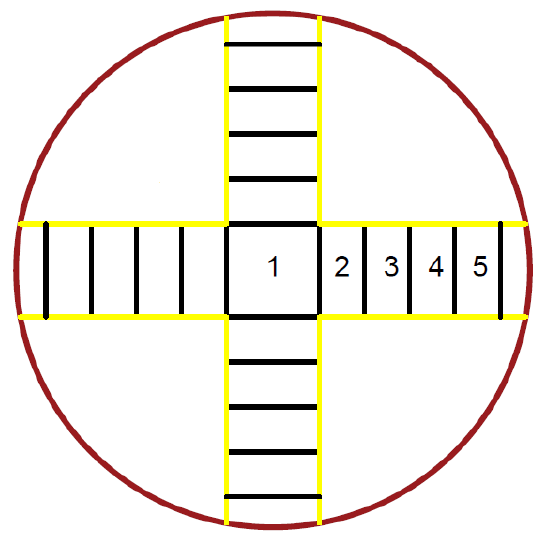
Figure 1. Place of sampling – Distance from center.